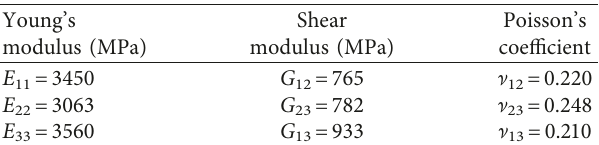
Table 3: Mechanical properties adopted for external masonry